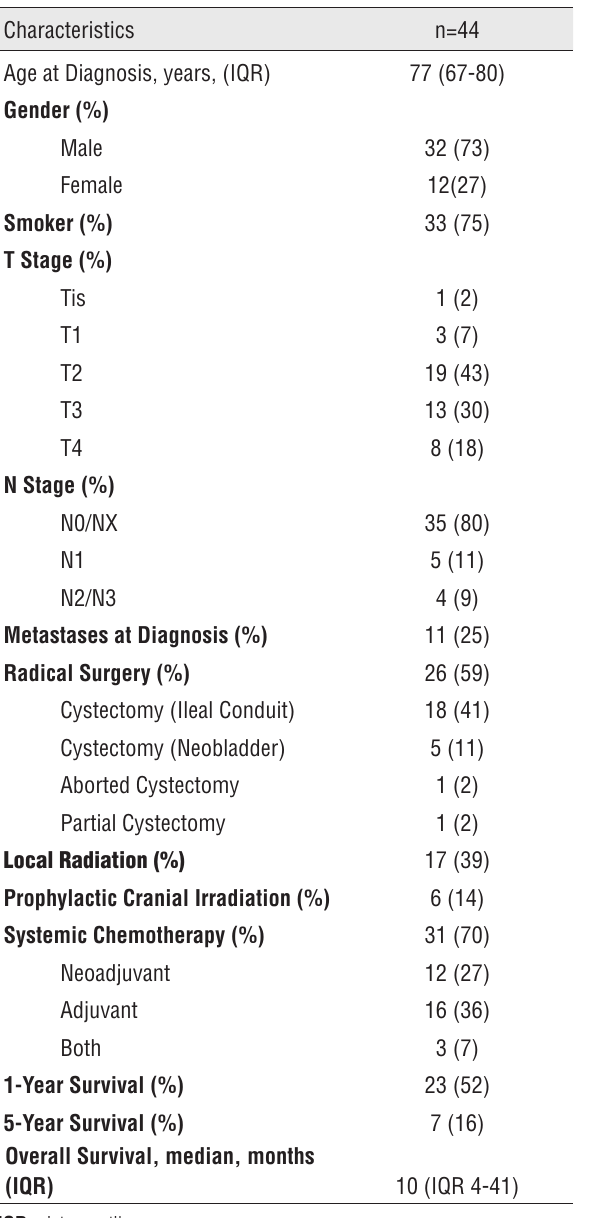
Table 1 - Characteristics of study population. Table 2 - Characteristics of patients treated with prophylactic cranial